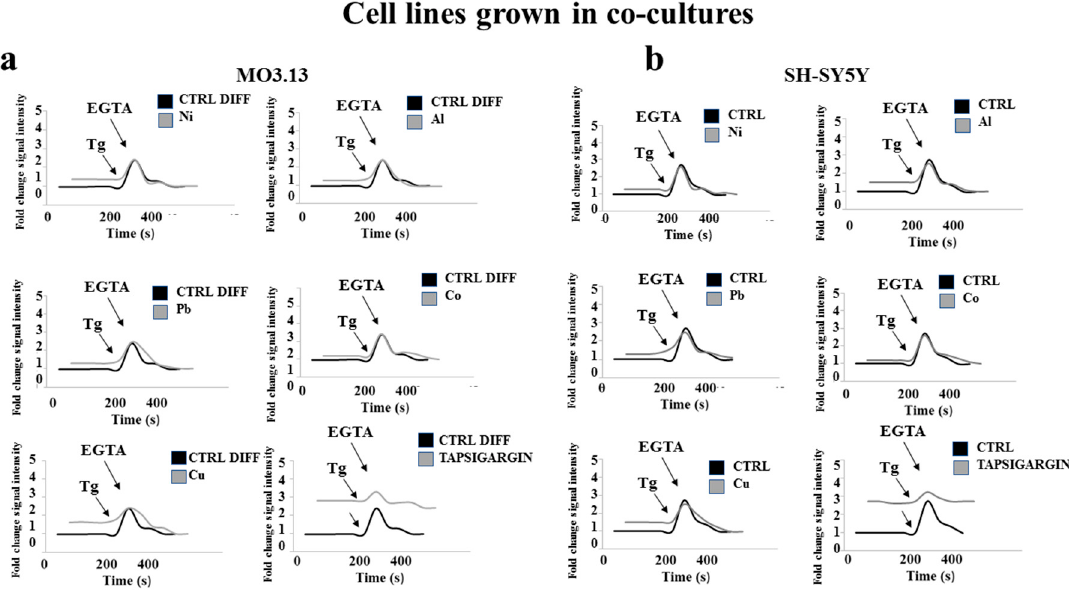
Figure 11. Measurement of the cytosolic calcium of oligodendrocytes and neurons grown in co-culture. Di ff erentiated human oligodendrocytes and human neurons were grown in co-culture and treated with heavy metals for 24 h. At the end of the treatment, the cells were exposed to Rhod 2 and subjected to flow cytometric analysis. The cells were then exposed to 1 µ M thapsigargin for 200 s and a new flow cytometric reading was performed. After 100 s, ethylene glycol-bis( β -aminoethyl ether)-N,N,N (cid:48) ,N (cid:48) -tetraacetic acid (EGTA) 500 µ M was added to chelate calcium. A new flow cytometric reading was conducted. Panel ( a ) shows the curves built on the achieved results from the flow cytometric readings performed on oligodendrocytes in the experimental conditions described above. Each graph refers to a di ff erent metal as shown in the figure. Panel ( b ) shows the curves built on the values obtained from the flow cytometric readings performed on neurons under the experimental conditions described above. Each graph refers to a di ff erent metal as evidenced in the figure. Values of three independent experiments are indicated. A representative image is shown. Analysis of Variance (ANOVA) followed by the Tukey-Kramer comparisons test.